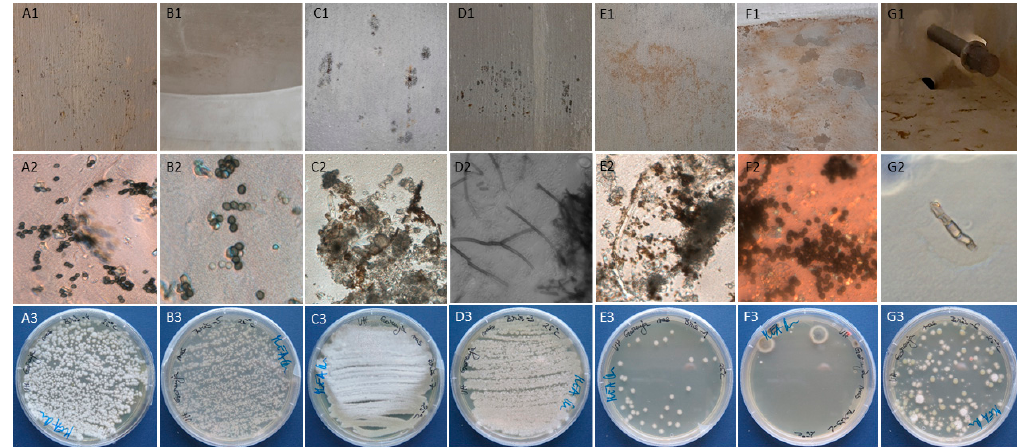
Figure 3. Presence of fungi inside concrete water storage tanks. Fungal growth with visible mycelia was observed as black and ochre colonies on concrete ceilings at the entrance ( A1 ) and inside the cell ( B1 ), on a dry wall ( C1 ), humid wall ( D1 ), and wet wall ( E1 ). Samples were taken also from the bottom of the tank ( F1 ) with visible peeling and change of the colour and from the metal pipe for water outflow ( G1 ). A2–G2: Microscopic observation of adhesive tape samples revealed diverse mycobiota producing brown conidia and brown to hyaline hyphae at all sampling sites. A3–G3: Fungal colonies on MEA medium grown from swab samples taken from 1 cm 2 surface.